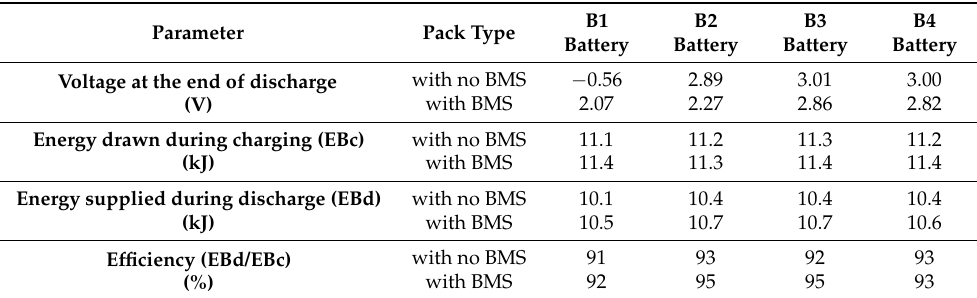
Table 2. Comparison of the measurement results of the tested battery pack with- and without the BMS.